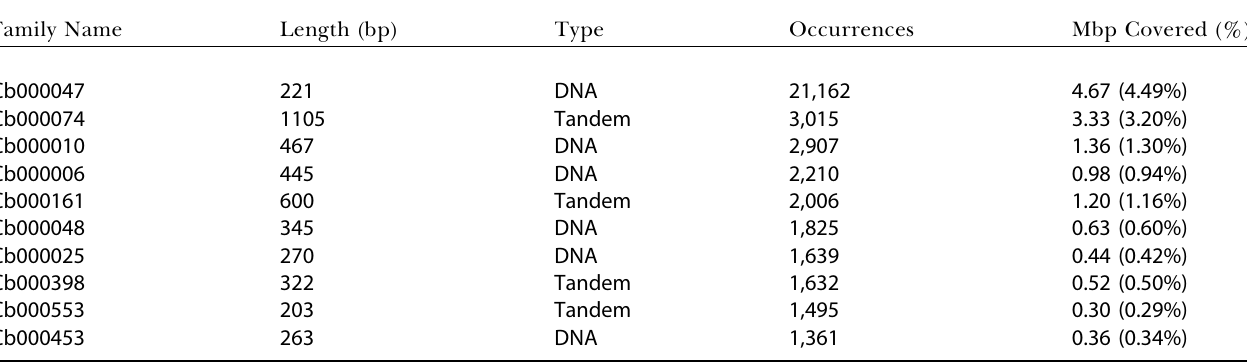
Table 6. Top Ten Most Abundant Repeat Element Families in C. briggsae